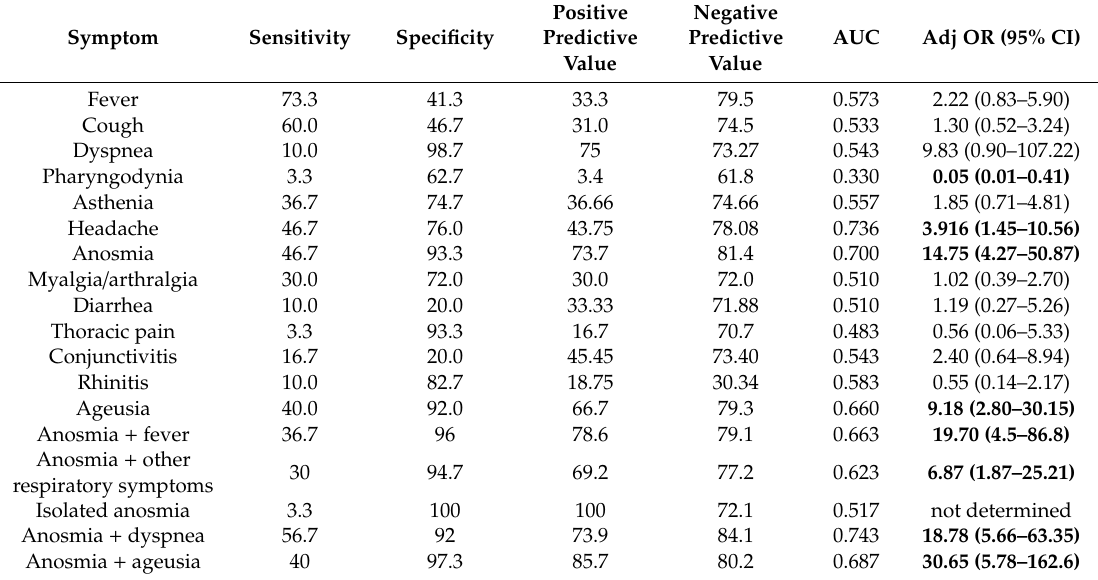
Table 3. Diagnostic characteristics of symptoms.